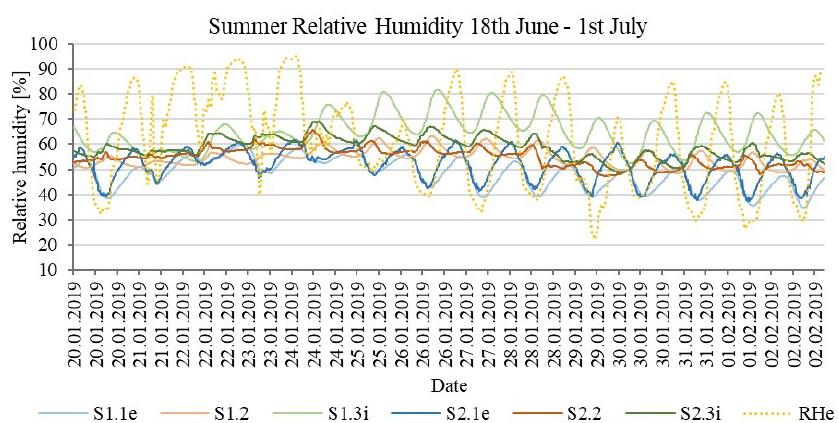
Figure 9. Comparison of the relative humidity in the summer